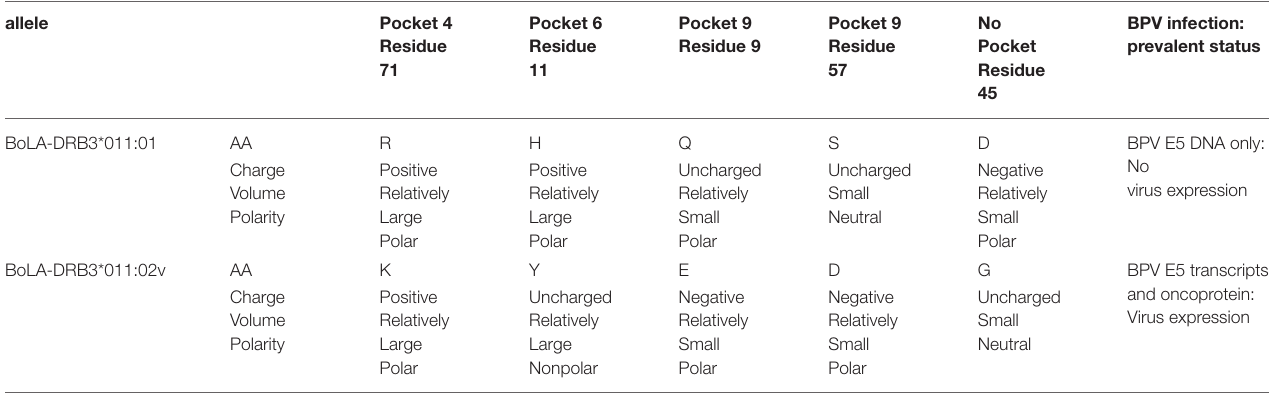
TABLE 2 | DRB3.2*22 allele and bovine papillomavirus (BPV) infection status.